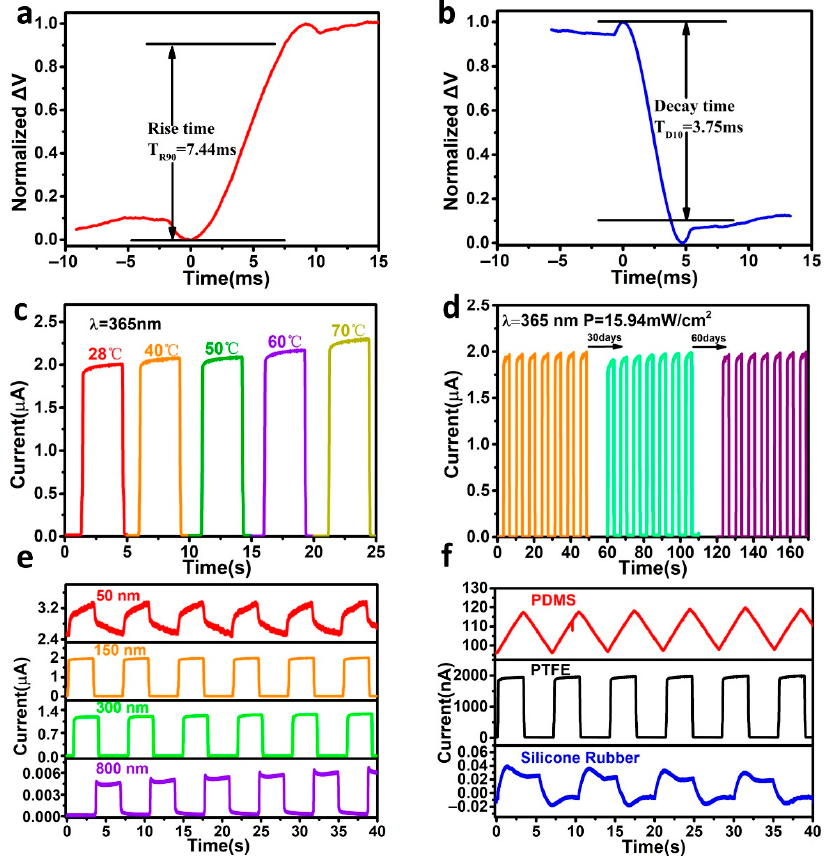
Figure 4. Response speed and stability of the IEFB-SP photodetector with PTFE and dielectric material influence. The rise time ( a ) and the decay time ( b ) of the IEFB-SP photodetector with PTFE; ( c ) Photocurrents of the IEFB-SP photodetector with PTFE at different temperatures; ( d ) Photocurrents of IEFB-SP photodetector with PTFE in air environment for 30 and 60 days; ( e ) Photocurrents of the device with different PTFE thicknesses (50, 150, 300, and 800 nm); ( f ) Photocurrents of IEFB-SP photodetector with different dielectric materials.